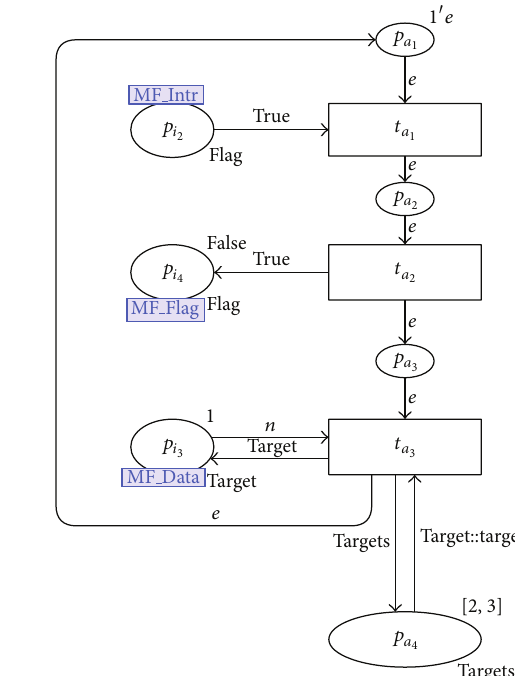
Figure 7: The ARM system’s CPN